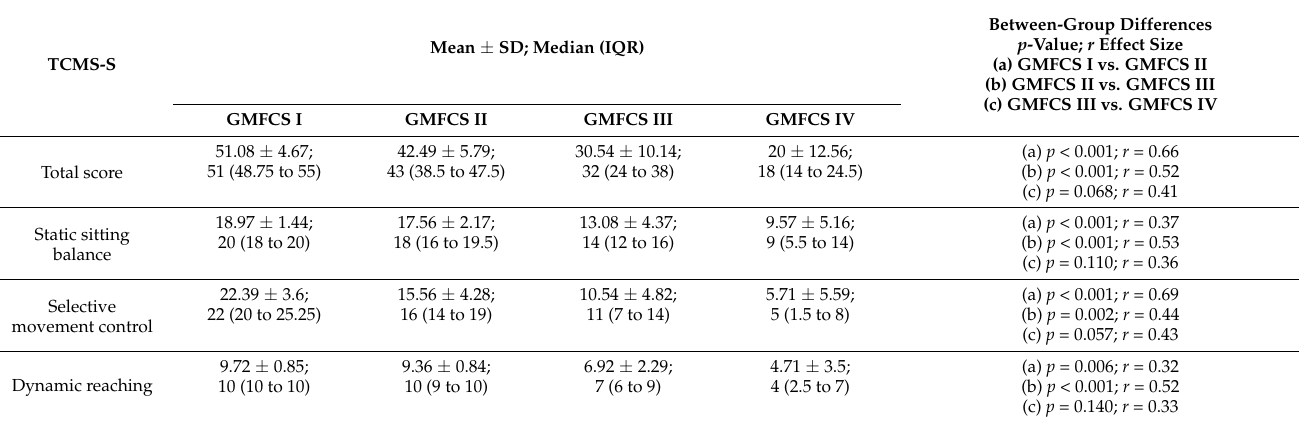
Table 2. Descriptive statistics and consecutive pairwise comparisons between children with different degrees of functional limitations according to the GMFCS for the Spanish version of the Trunk Control Measurement Scale.